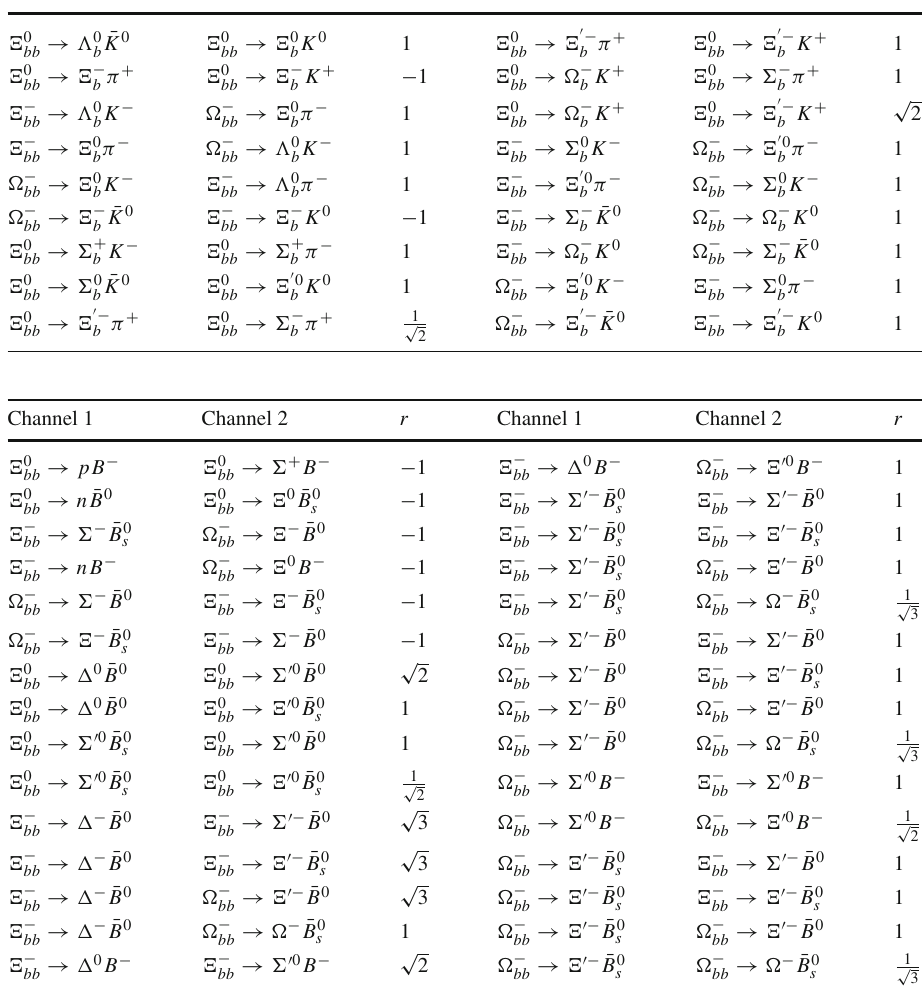
Table 21 U-spin relations for (cid:2) ,(cid:5) bb bb decays into a bottom baryon and a light meson. Results in the “channel 1” are for b → d processes and the ones in the “channel 2” are for b → s processes. r denotes the ratio of the two amplitudes